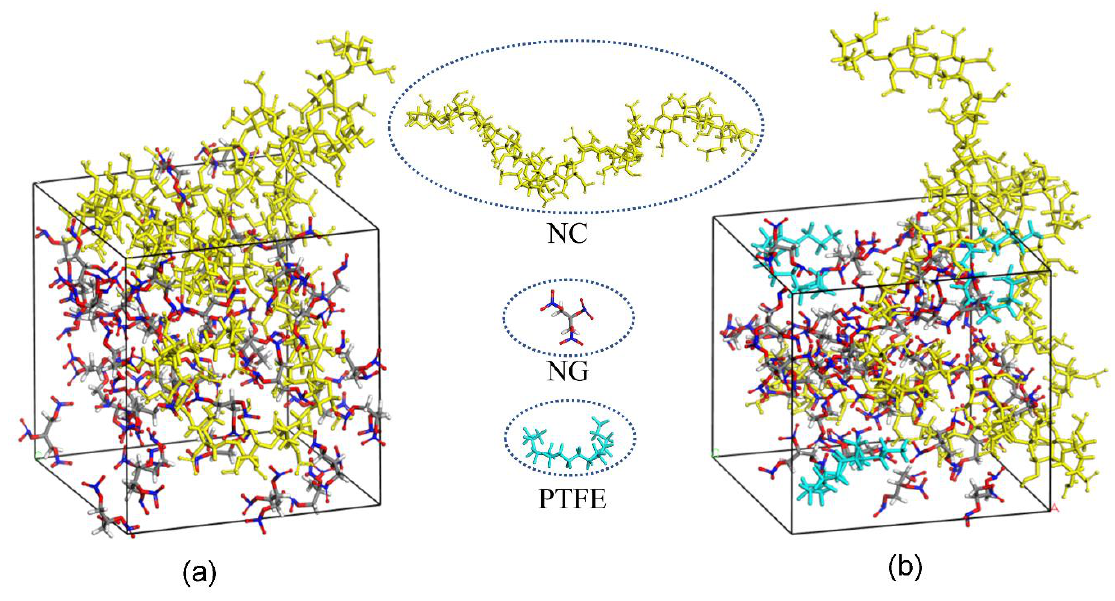
Figure 7. Modeling for the amorphous cells of NC/NG ( a ) and PTFE/NC/NG ( b ) in MD simulations. Table 6. Diffusivity of NG calculated from MD simulation.